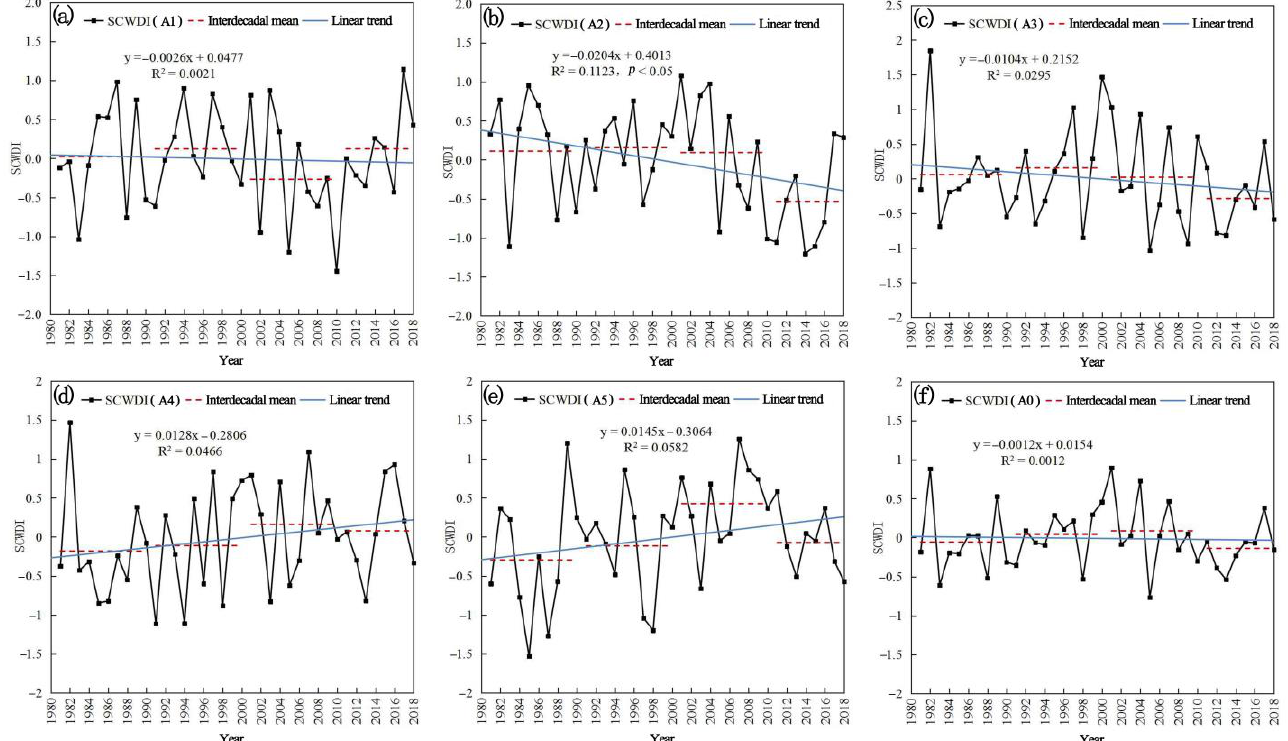
Figure 5. Temporal variation characteristics of SCWDI in different growth stages of spring maize: ( a ) the sowing to seedling stage; ( b ) the seedling to jointing stage; ( c ) the jointing to heading stage; ( d ) the heading to milk mature stage; ( e ) the milk mature to mature stage; and ( f ) the whole growth stage.